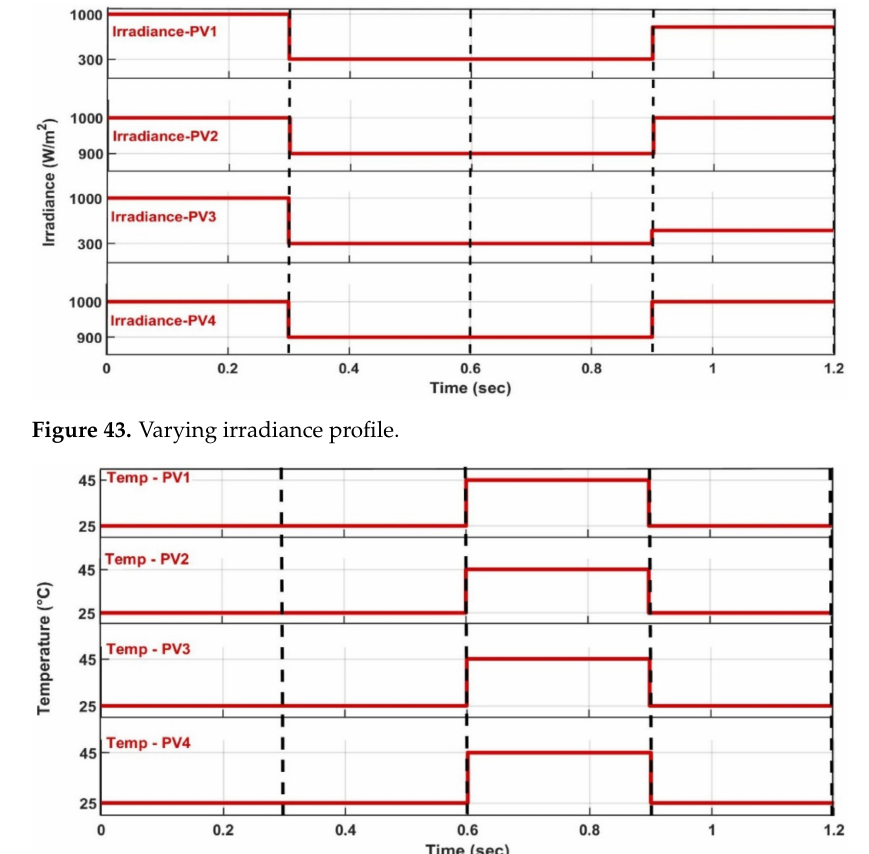
Figure 44. Varying temperature profile.